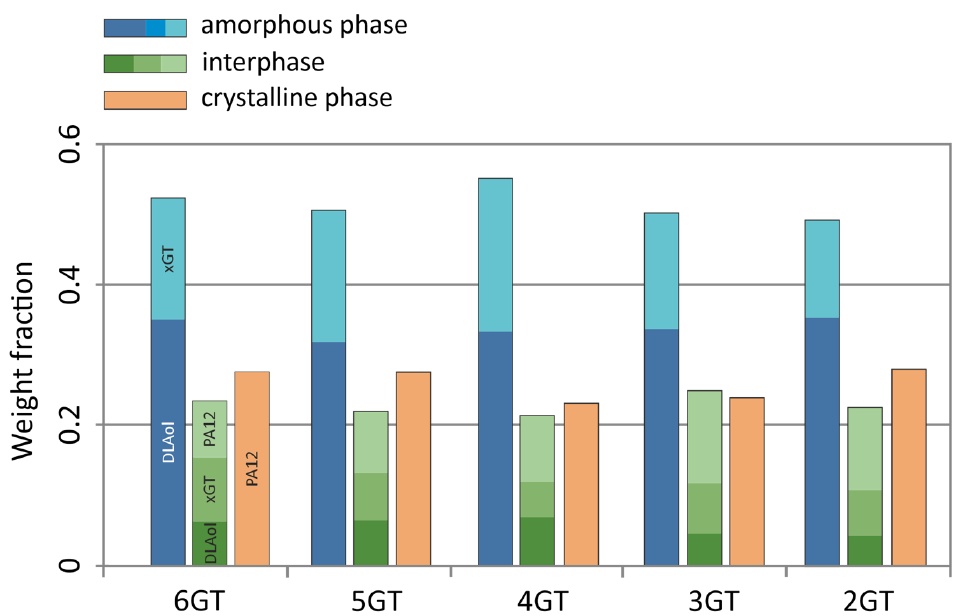
Figure 13. The phase compositions of the terpolymers of series II.